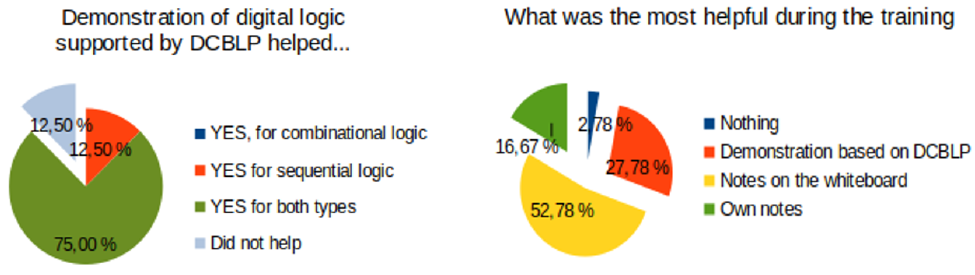
Figure 10. Questions related to sensing the demonstration